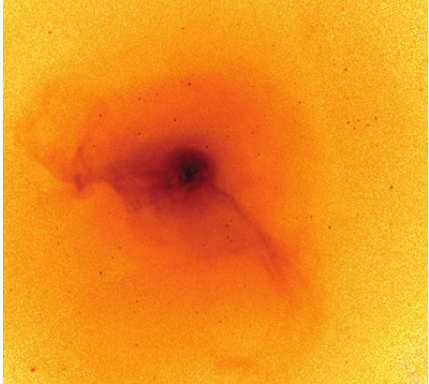
Figure5:AChandraX-RayObservatoryimageofthegiantelliptical galaxy M87 in the constellation Virgo. (provided by W. Forman of CfA). There is a large X-ray halo as well as features created by episodic outbursts emanating from a giant black hole at the center [28]. The field is about 10 arc minutes. The distance to M87 is about 16.4 Mpc (53 million light years).